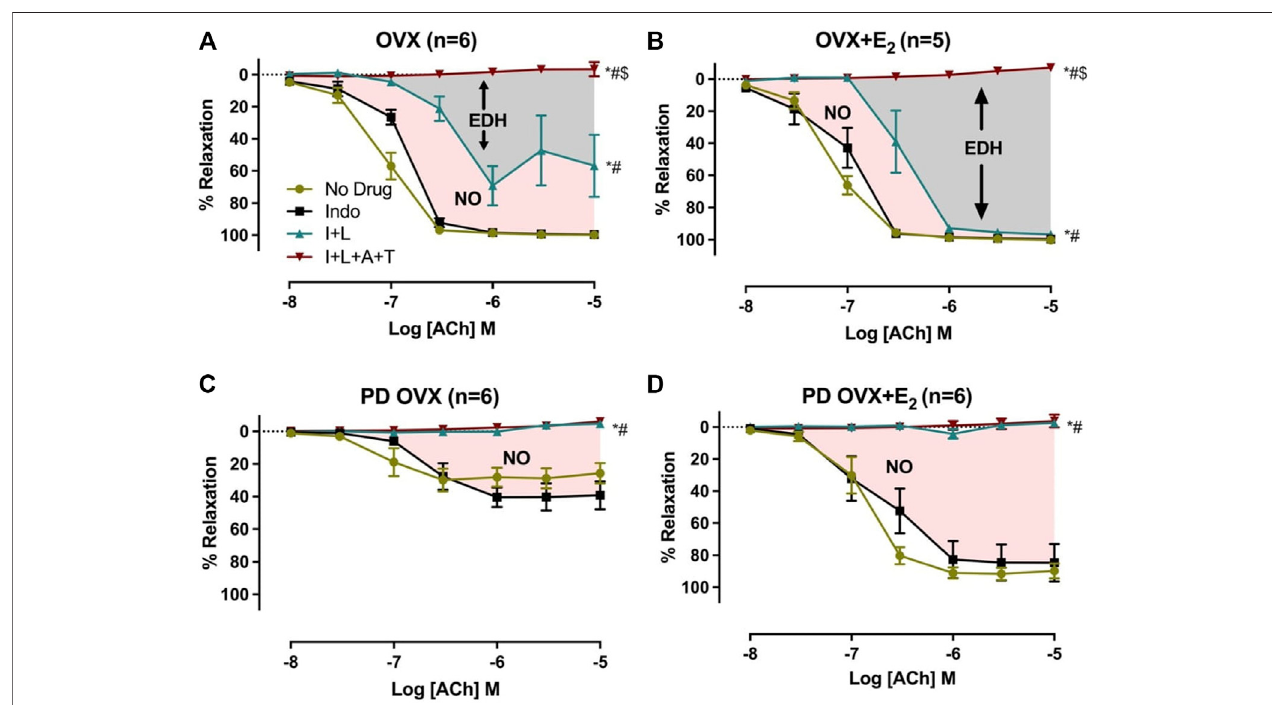
FIGURE 4 | Effects of inhibiting cyclooxygenase (COX), nitric oxide synthase (NOS), small conductance and intermediated conductance calcium activated potassium channels (SKca and IKca) on acetylcholine (ACh)-induced vasorelaxation in mesenteric arteries taken from ovariectomized (OVX) and E 2 replaced (OVX+E 2 ) control and prediabetic (PD) rats; (A) OVX (B) OVX+E 2 (C) PD OVX (D) PD OVX+E 2 . Concentration response curve (CRC) to ACh (10 − 8 to 10 − 5 ) was generated in the absence (No drug) or in the presence of indomethacin (Indo), Indo+L-NAME (I+L), and Indo+L-NAME+Apamin+TRAM-34 (I+L+A+T) in mesenteric arterial rings. Indo (indomethacin; 10 μ M), L-NAME (N ω -nitro-L-arginine methyl ester; 200 μ M), Apamin (1 μ M), TRAM-34; [1-{(2-Chlorophenyl) diphenylmethyl}-1H-pyrazole; 1 μ M]. Data are expressed as mean ± SEM. n = 5 – 6 animals per group. * (P < 0.05) vs. no drug; # (P < 0.05) vs. Indo; $ (P < 0.05) vs. Indo+L-NAME, analyzed using 2-way ANOVA repeated measures followed by Bonferroni ’ s post hoc test. NO, nitric oxide; EDH, endothelium-dependent hyperpolarization.